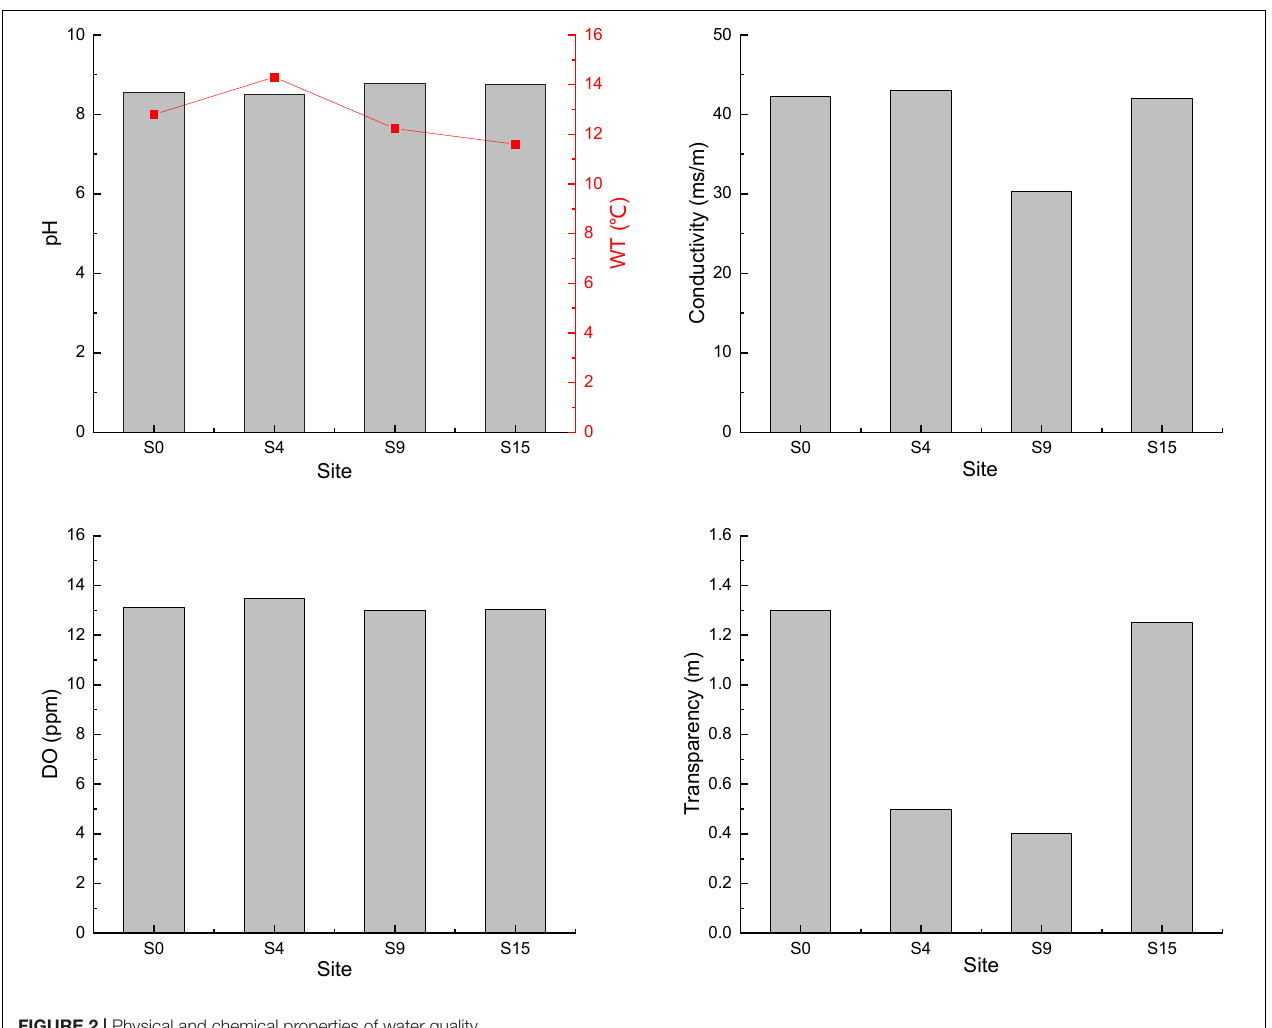
FIGURE 2 | Physical and chemical properties of water quality.